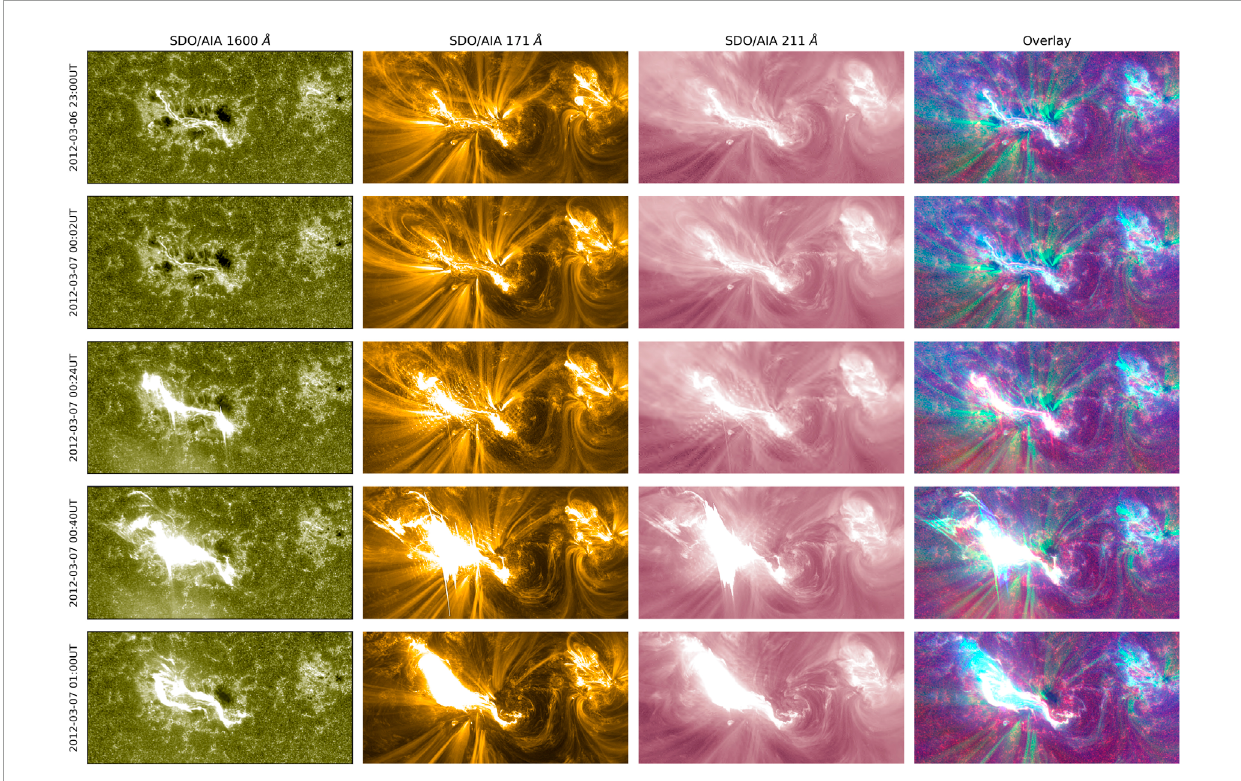
FIGURE 2 Imagery from the 1,600 Å, 171 Å, and 211 Å AIA channels, as well as the overlaid image, for (1st row) 1 hour before flare start, (2nd row) flare start time, (3rd row) 6 minutes after flare start, (4th row) flare max time, and (5th row) flare start time.